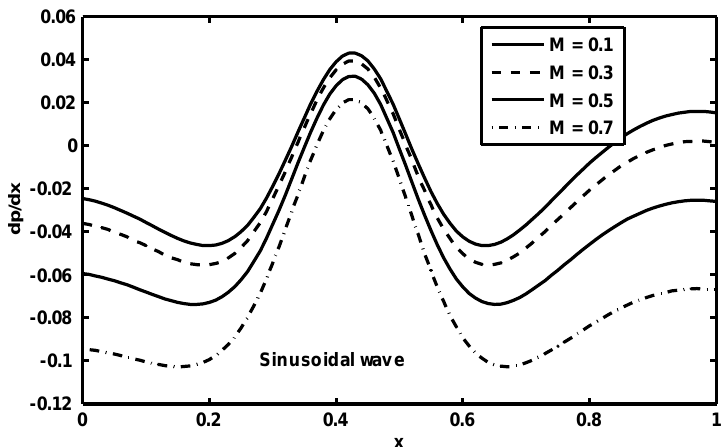
Figure 7. Variation of dxdp / with x for different values of M for fixed